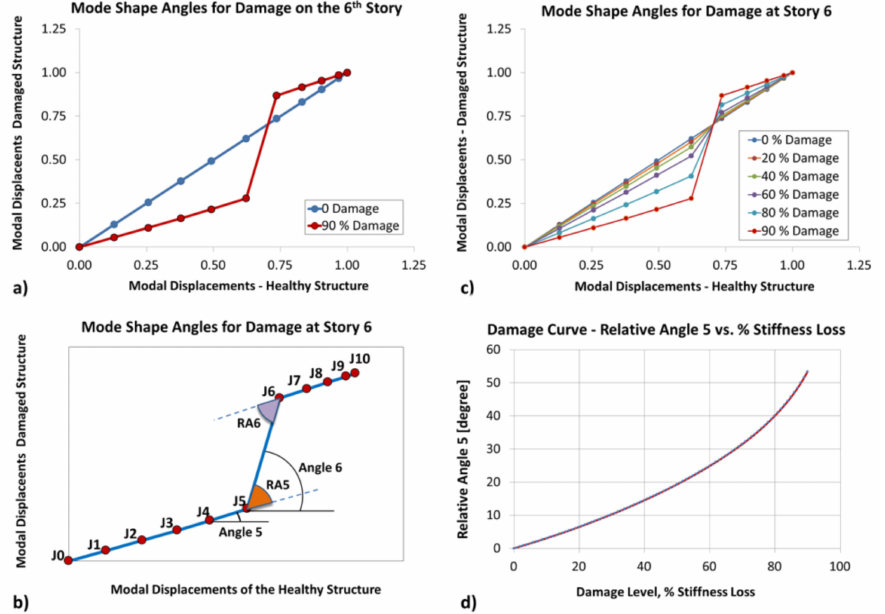
Figure 8. The mode shape variation analysis with respect to damage location. ( a ) damage effect on mode shape angle ( b ) angle notation used in the analyses ( c ) increase in the angle depending on the damage ( d ) reference damage